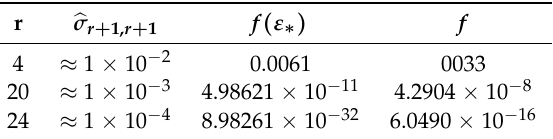
Table 8. The table show the behaviours of the codes when we recover the matrix M fixing different values of the rank, accordingly with the order of magnitude of the singular value of the exact full rank solution A